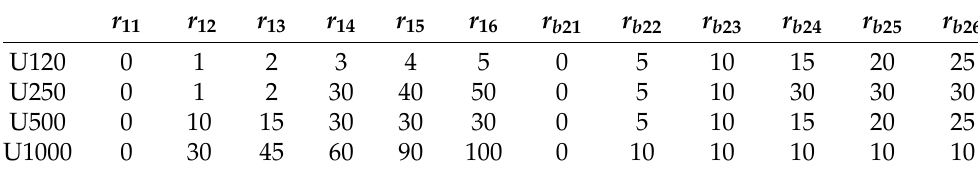
Table 4. Parameter setting for the Falkenauer U class in lines 1–13.